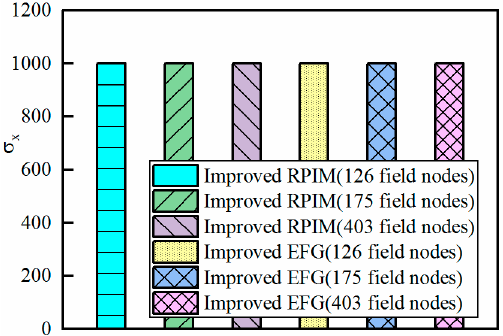
Figure 9. Investigation on sensitivity of stress solution to number of field nodes.